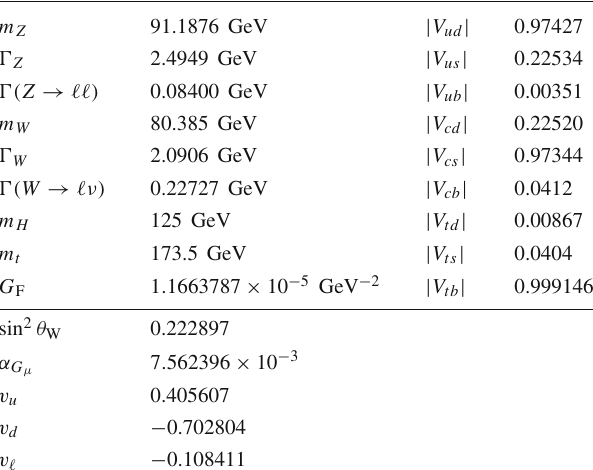
Table 15 Electroweak input parameters, in the G μ scheme, for the NC and CC Drell–Yan pp and deep inelastic ep scattering cross- section calculations, see text. Standard Model parameters are taken from Refs. [39,100], except (cid:16)( W → (cid:3)ν) . The V ij symbols denote the elements of the CKM matrix. The parameters below the line, the weak mixing angle sin 2 θ W , the fine-structure constant α G μ , and the vector couplings of up-type quarks v u , down-type quarks v d , and charged lep- tons v (cid:3) to the Z boson, are calculated at tree level from the ones